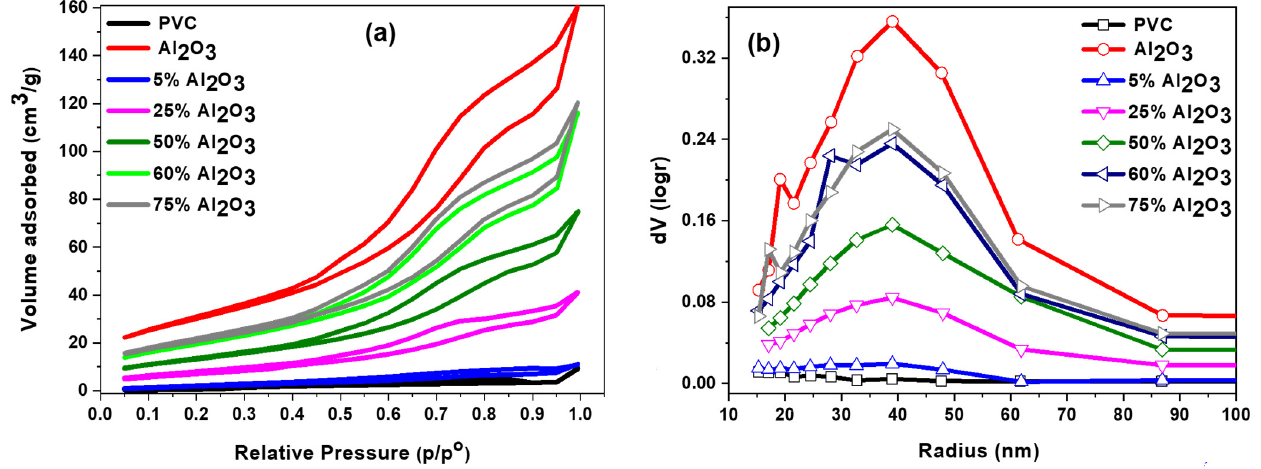
Figure 4. Nitrogen adsorption/desorption isotherms ( a ) and BJH pore size distribution ( b ) of Al 2 O 3 /PVC catalyst with different amounts of Al 2 O 3 .